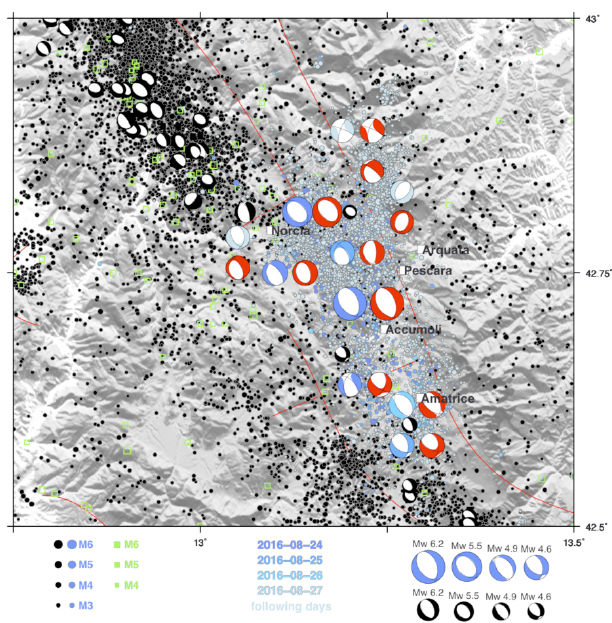
Figure 1. Map of seismicity, QRCMTs and RCMTs of the Amatrice region. QRCMTs are in blue to light blue (different shades are for different days of occurrence, following the label below the map), revised RCMTs are in red. In black are focal mechanisms for previous earthquakes with M > 4.0 (European-Mediterranean RCMT Catalog, http://www.bo.ingv. it/ RCMT). Green squares are historical events, scaled with magnitude (Rovida et al., 2016; http://emidius.mi.ingv.it/CPTI15). Background seismicity is mapped with black circles for events before Amatrice main shock, while in different blue shades are mapped events of the Amatrice seismic sequence (M>2.0, ISIDE WG, 2016; http://iside.rm.ingv.it/iside/standard/index.jsp). Mw Depth Mw final RCMT (cid:1) ML Date Time Lat. Long. QRCMT (km)